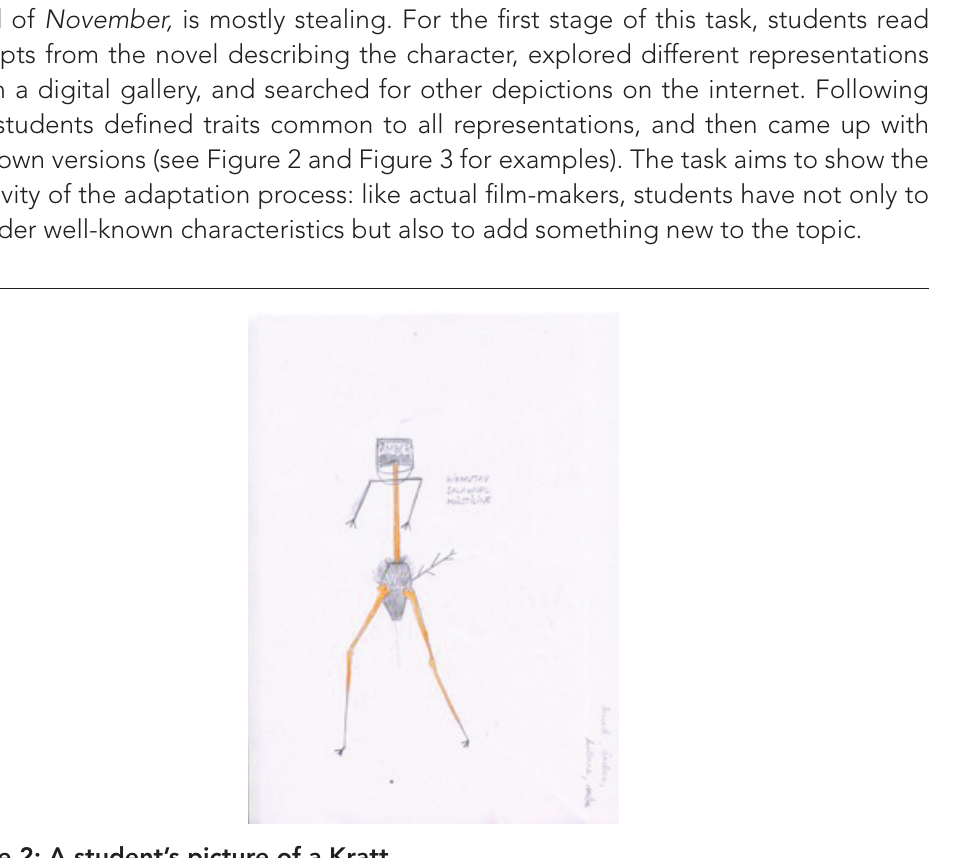
Figure 2: A student’s picture of a